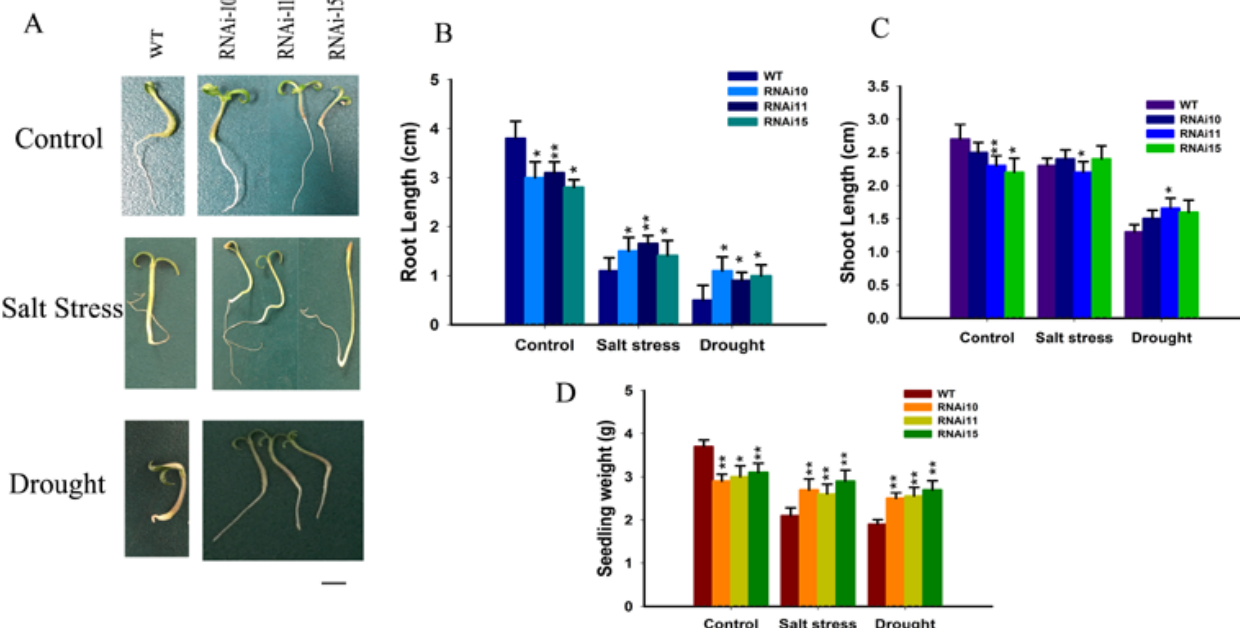
Figure 5. Down-regulation of SlGRAS10 enhances seedling growth to salt and drought stress. ( A ) The figure shows the growth performance of wild-type and SlGRAS10 -RNAi-10. RNAi-11 and RNAi-15 seedlings under salt and drought stress after 15 days. Scale bar = 1mm ( B ) Root length of SlGRAS10 -RNAi three lines and wild-type under control, salt stress, and drought treatments (n = 20). ( C ) Shoot lengths of SlGRAS10 -RNAi and wild-type under control, salt stress, and drought treatments (n = 20). ( D ) Seedling weight of SlGRAS10 -RNAi and after control, salt stress, and drought treatments (n = 20). The date represents the mean ± SE of three independent replicates. * , ** indicates a significant difference ( p < 0.05, p < 0.01) between transgenic and wild-type plants.